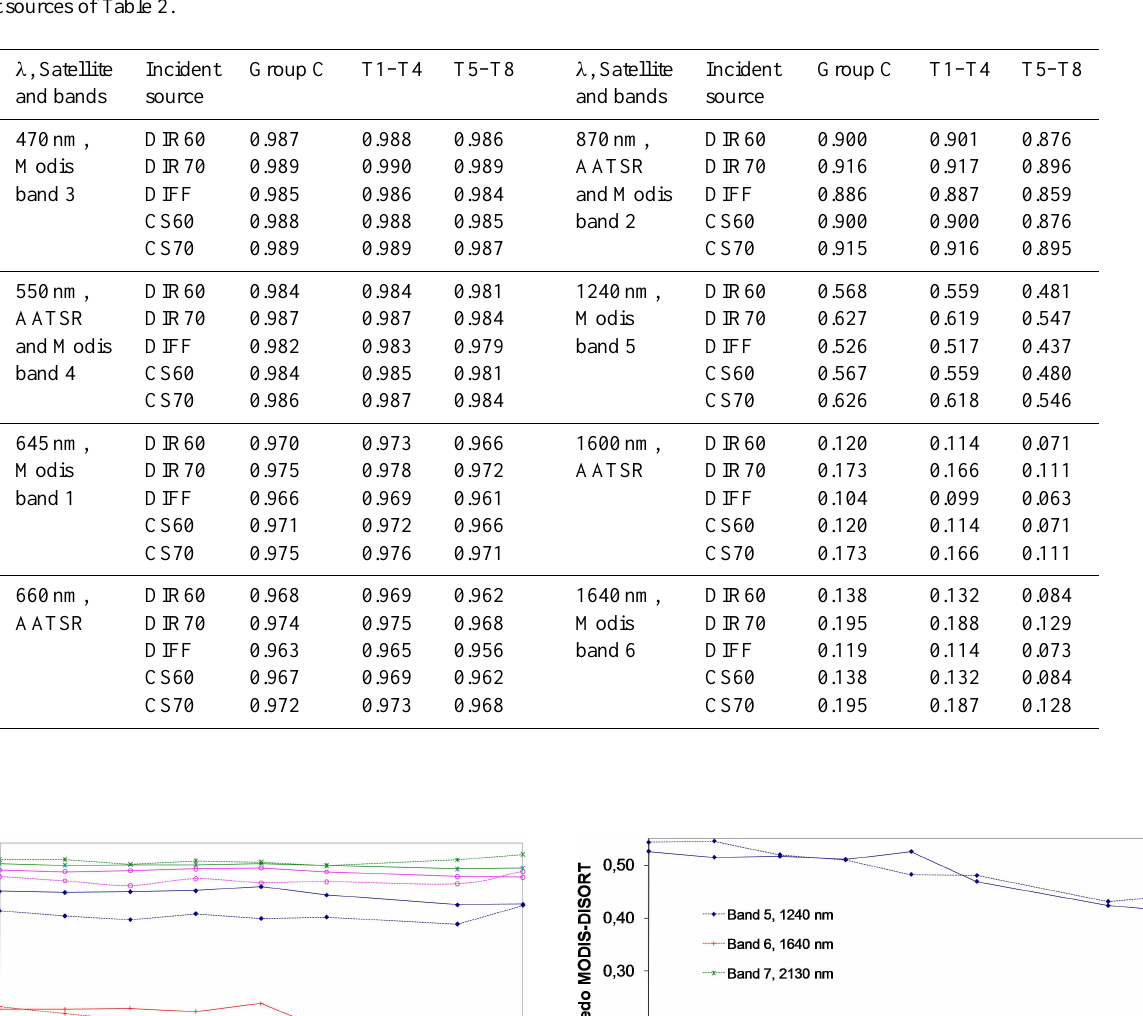
Table 3. Directional hemispherical reflectance of all mean pits calculated for the spectral bands of MODIS and AATSR satellites, and using the light sources of Table 2.